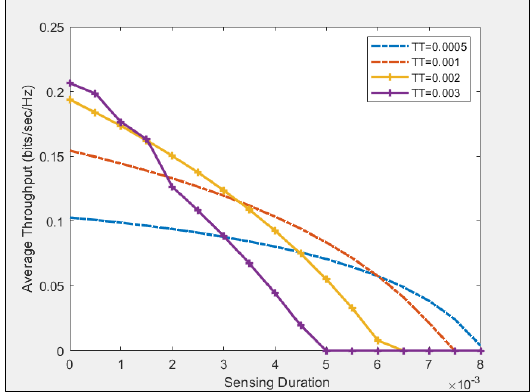
Figure 7. Average throughput vs. sensing duration.